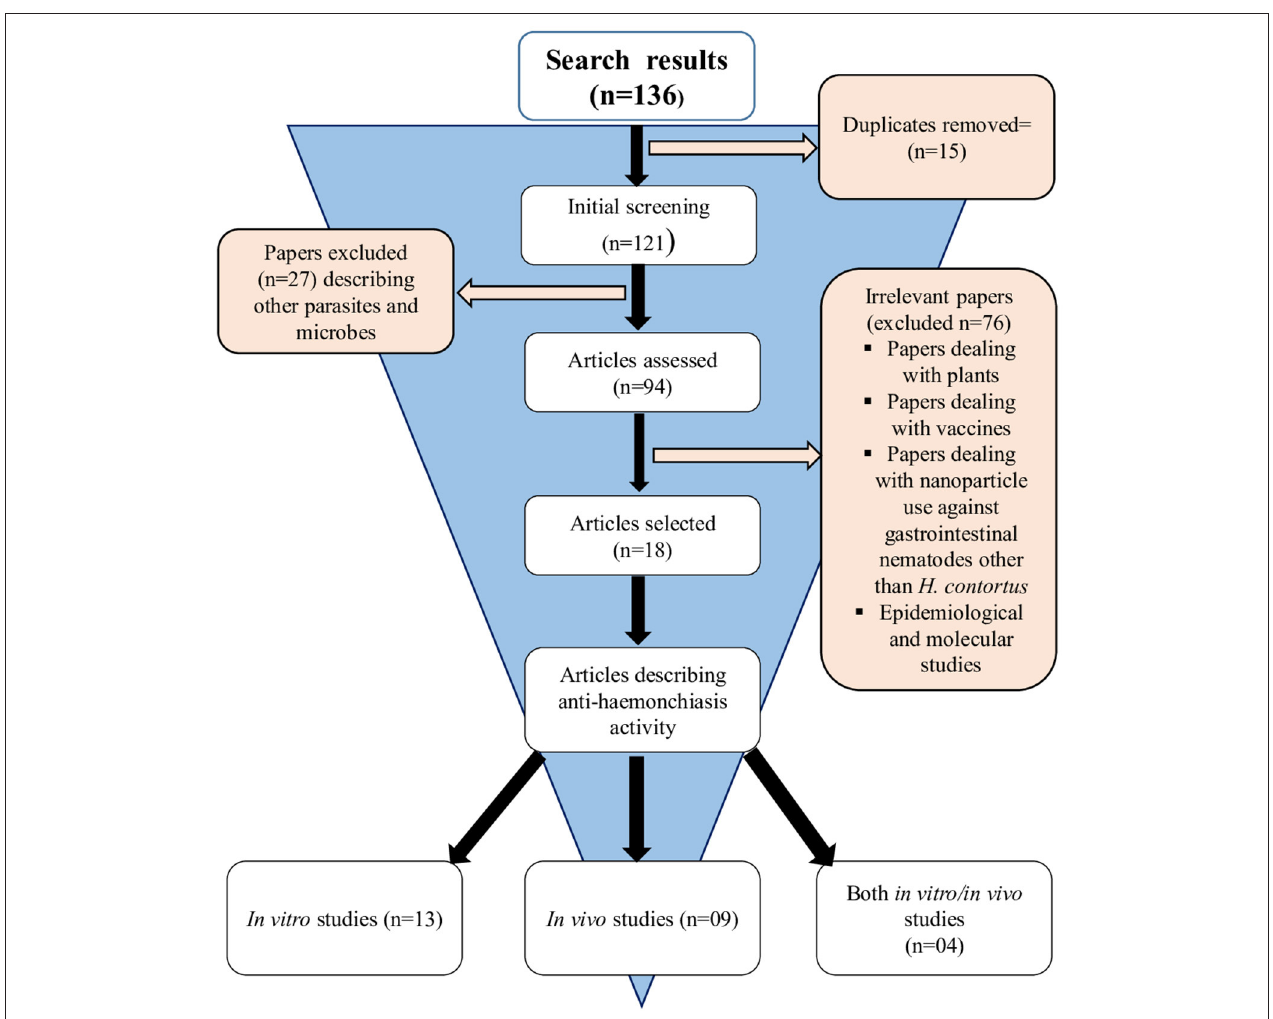
FIGURE 1 | Article screening and selection process used for conducting this systematic